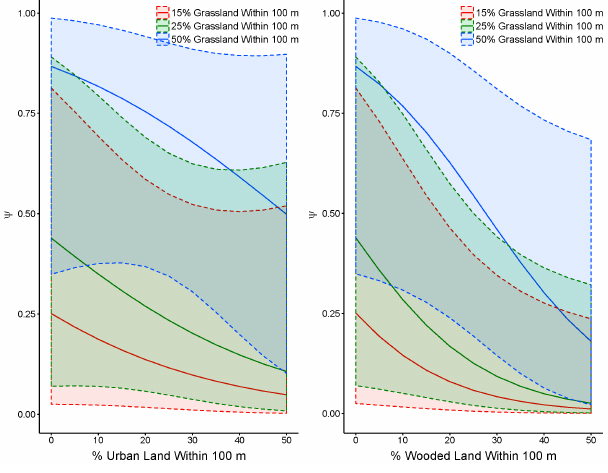
Fig. 6. Predicted relationship for Western Meadowlark initial probability of site occupancy based on the percentage of land within 100 m of study sites consisting of wooded lands (trees or shrubs) and urban land. Relationships are as determined by the best-ranked multiseason occupancy model for Western Meadowlark in 2008–2009. Prediction curves show increasing probability of occupancy ( Ψ ) with increasing amount of grassland within 100 m of